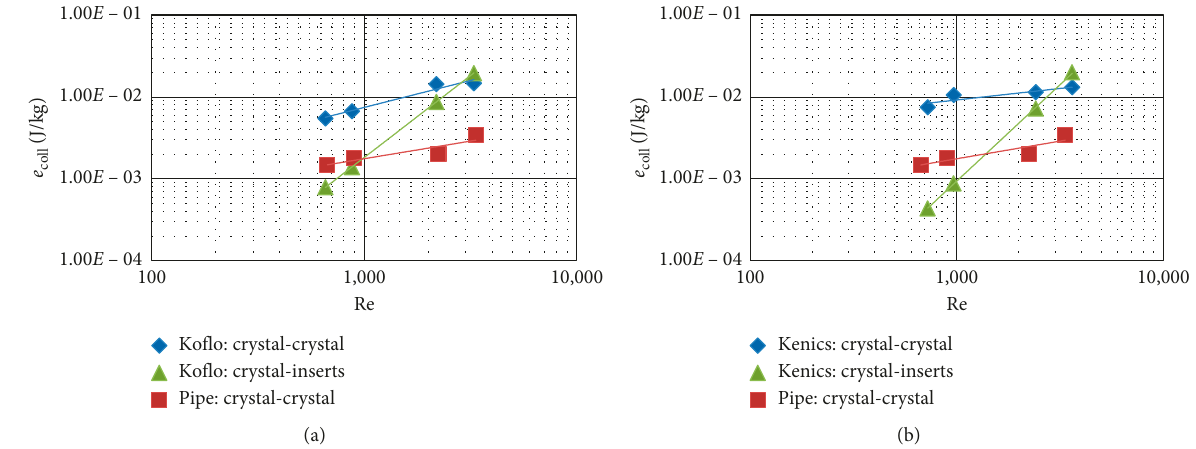
Figure 20: Mechanical collisions in static mixers and pipe for L Kenics and a pipe.